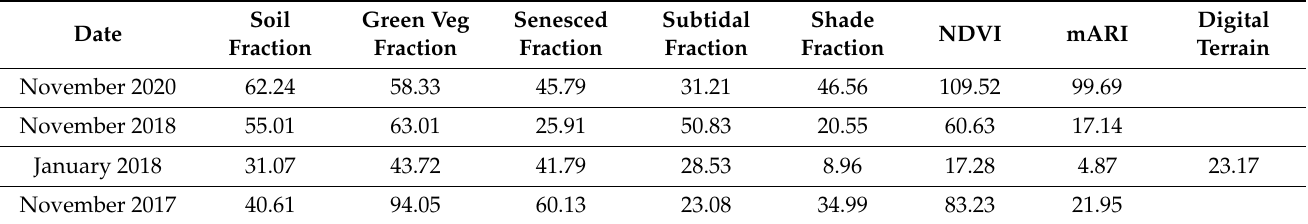
Table 3. Variable importance across dates (mean decrease in Gini index).